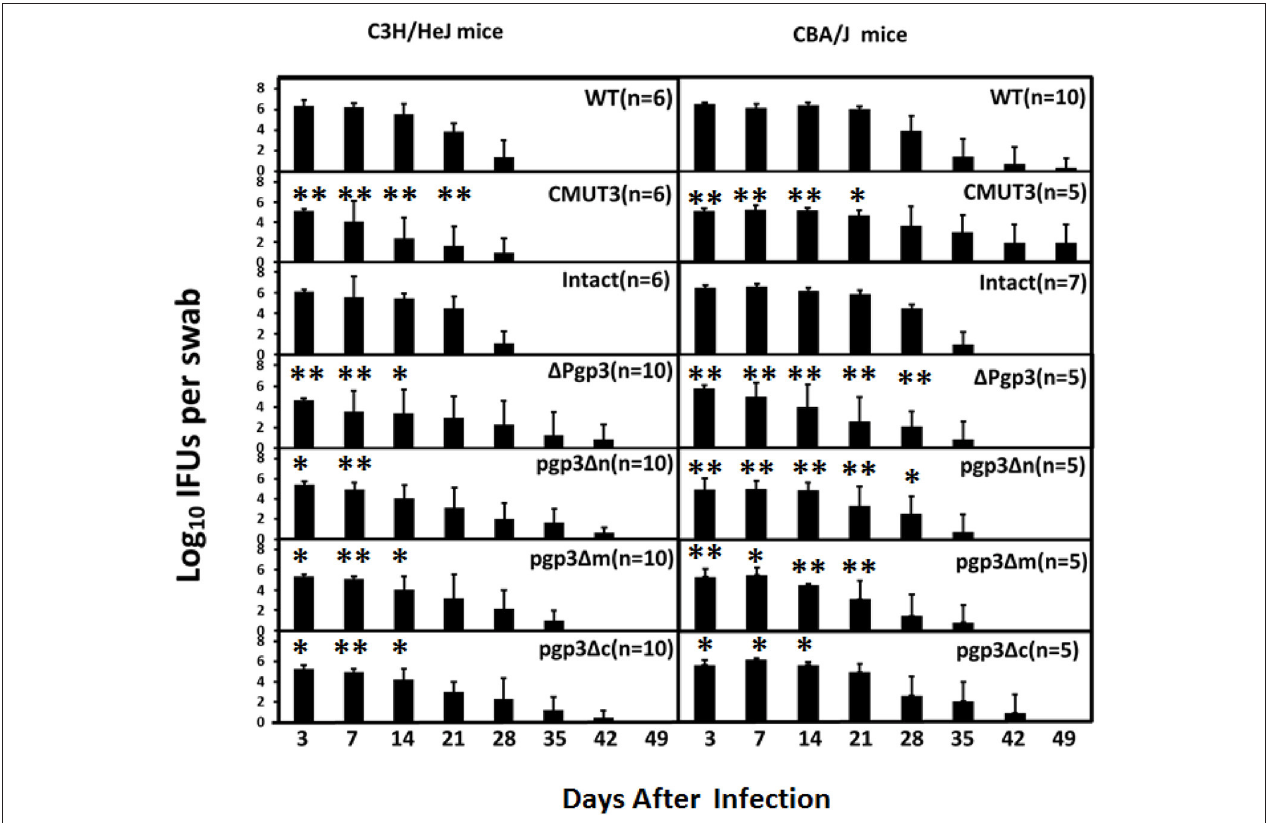
FIGURE 5 | Effect of Pgp3 domain deletion on shedding from the LGT. C3H/Hej and CBA/J mice were intravaginally infected with C. muridarum . On the indicated days postinfection, vaginal swabs were harvested, and live organisms were enumerated by infecting HeLa cell monolayers; the results are presented in log10 IFUs. Mice infected with 1 pgp3, pgp3 1 n, pgp3 1 m, pgp3 1 c, or plasmid-free CMUT3 shed significantly smaller numbers of live organisms compared with mice infected with intact organisms. * P < 0.05, ** P < 0.01; Kruskal–Wallis